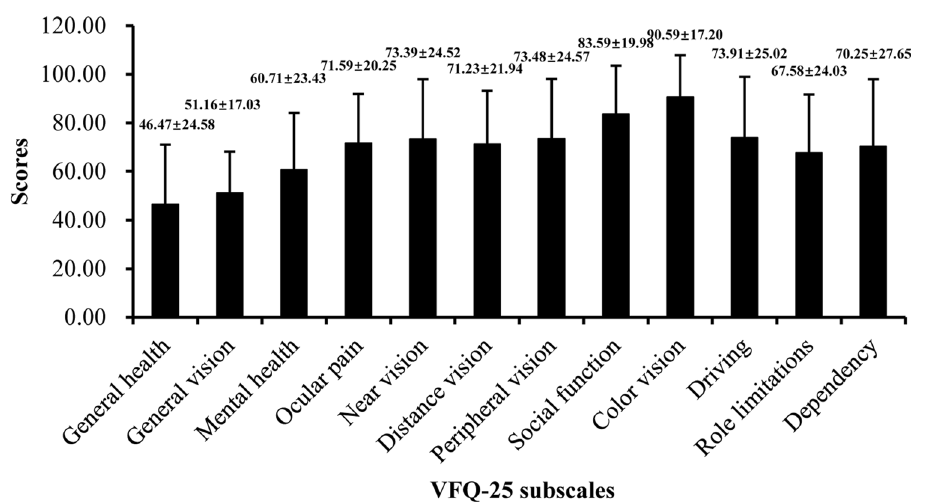
Figure 2. Averaging items to generate VFQ-25 subscales in KC